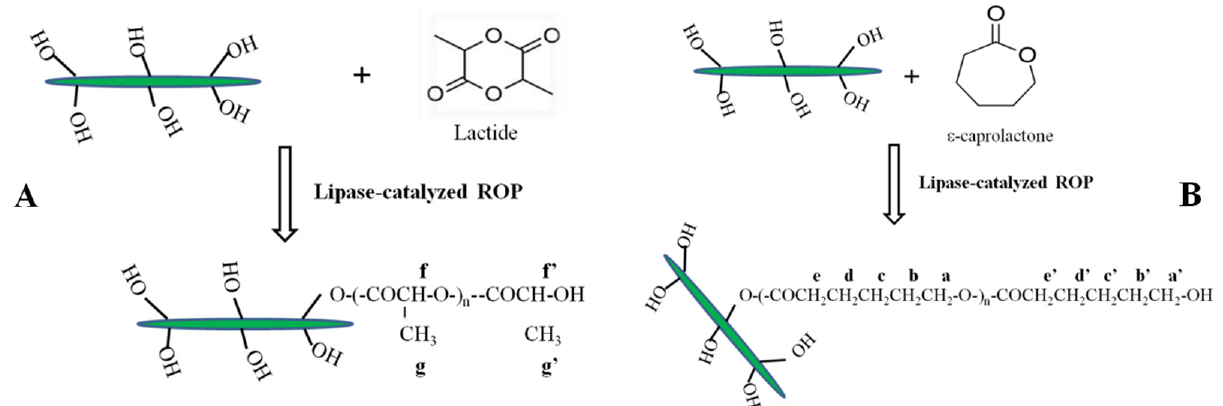
Scheme 1. Scheme of the green catalytic approach for the functionalization of the cellulose nanocrystals with PLLA chains ( A ) and PCL chains ( B ) grafted onto the external surface of the cellulose nanocrystals.